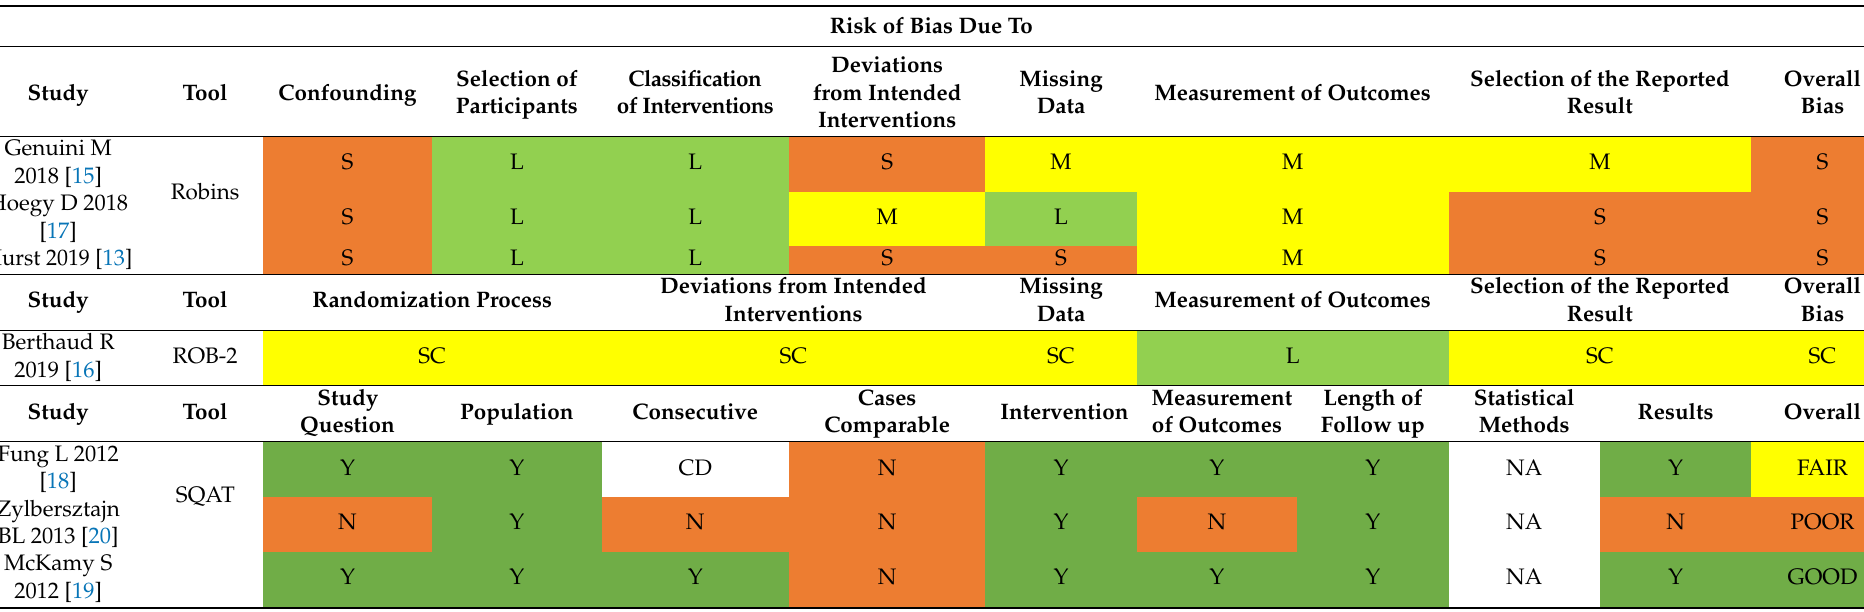
Table 1. Quality assessment of the